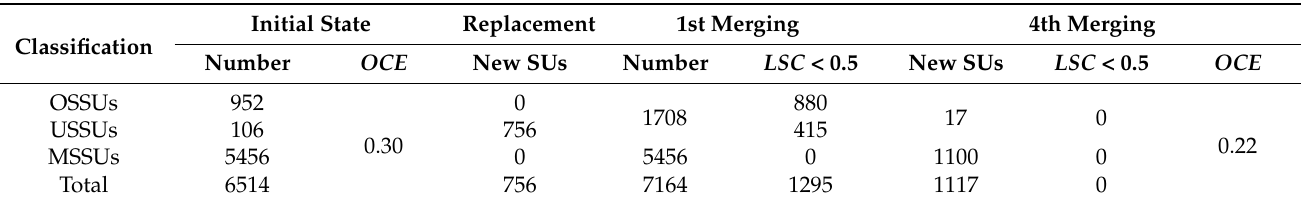
Table 5. Statistical table of gradual optimization process from OSSUs and USSUs to MSSUs.